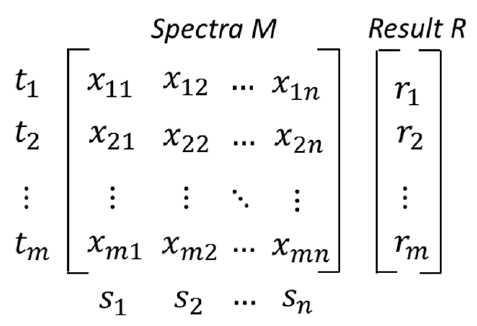
Figure 1. Program spectra M and testing result vector R .